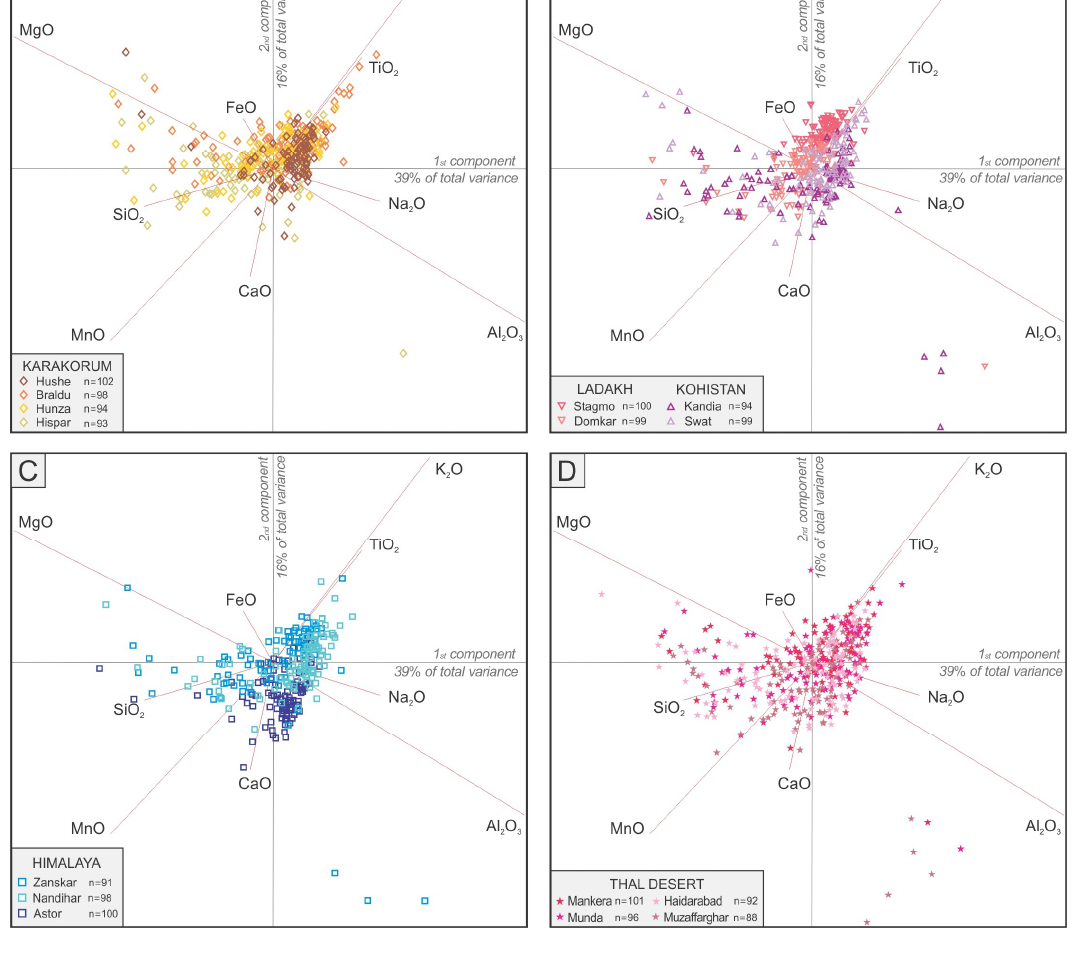
Figure 3. Chemical composition of detrital amphibole in river and eolian sands of northern Pakistan. All data were plotted in one single biplot [111], next separated into four panels to allow comparison between end-member sources ( A = Karakprum, B = Ladakh and Kohistan arcs, C = Himalaya) and the sediment sink ( D = Thal